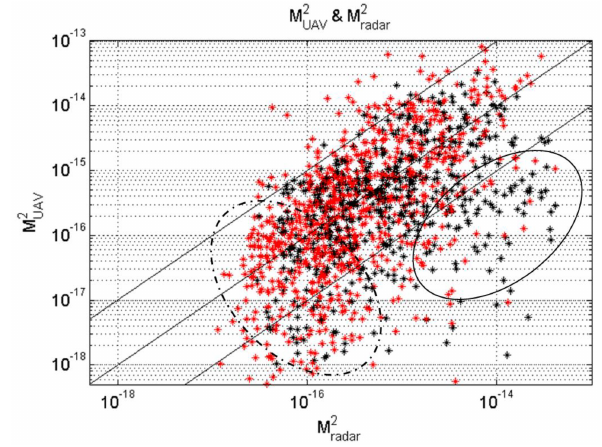
Figure 6. M 2 plotted against M 2 for the seven UAV flights radar UAV on 7 June 2015. Red markers correspond to data in the ST region. The (solid) ellipse focuses on the values mainly obtained in the KH and CL regions. The (dashed) ellipse shows the low values biased by the limitations of power